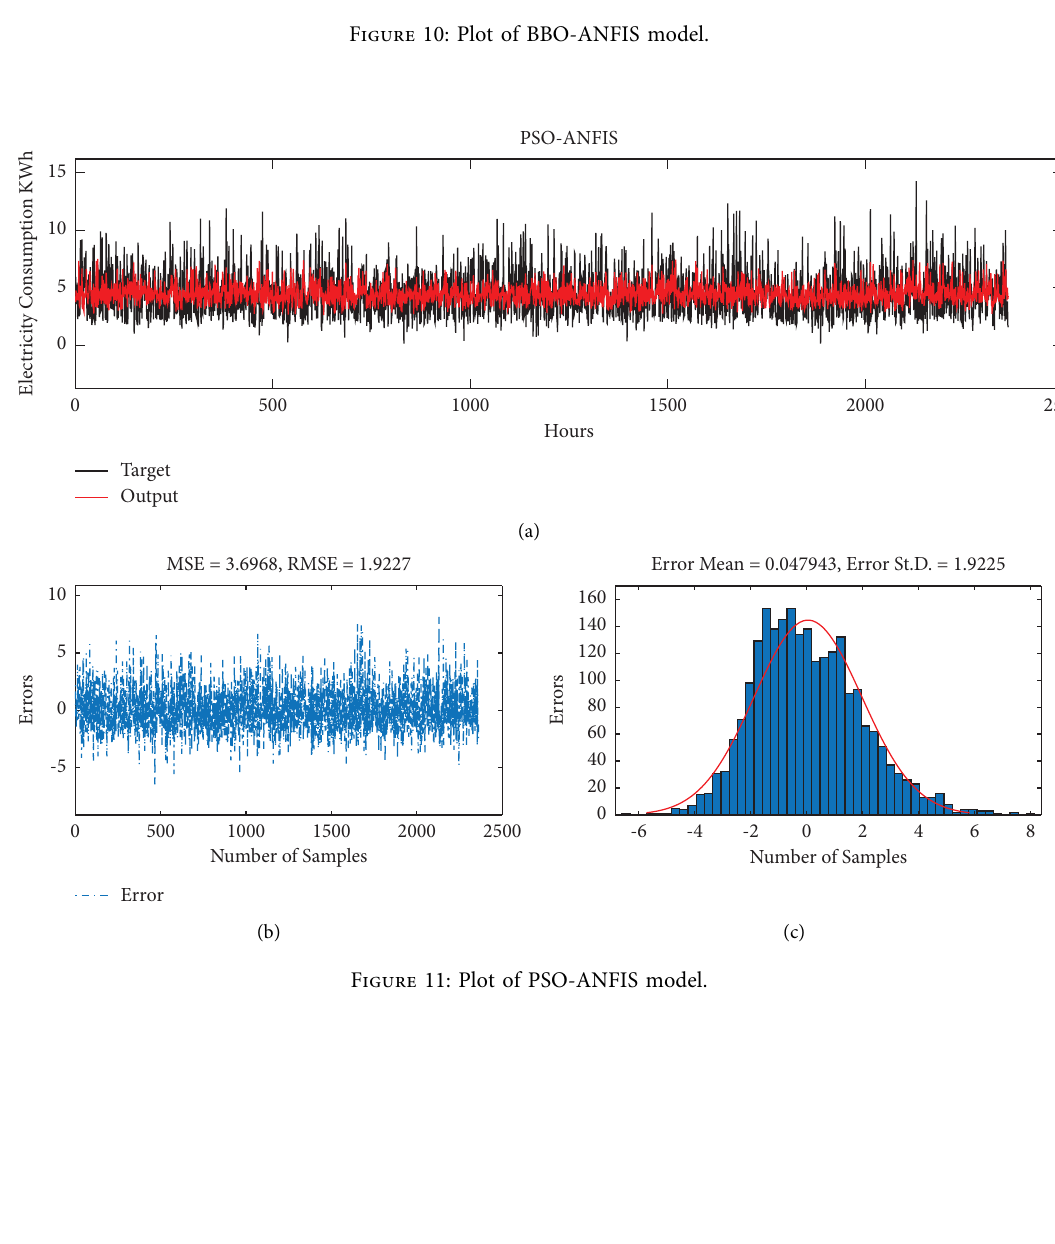
Figure 10: Plot of BBO-ANFIS model.